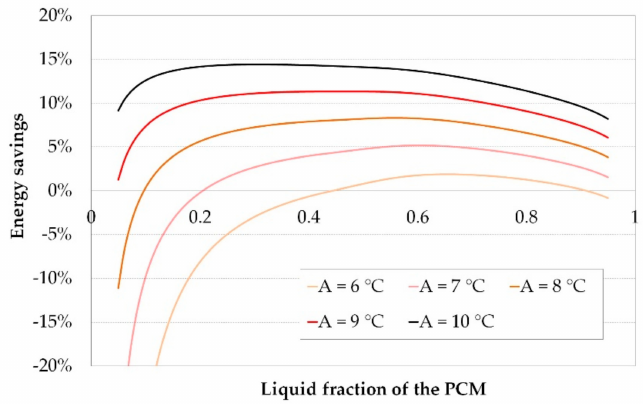
Figure 13. Energy savings obtained with the PCM mode for di ff erent values of daily temperature amplitude ( A